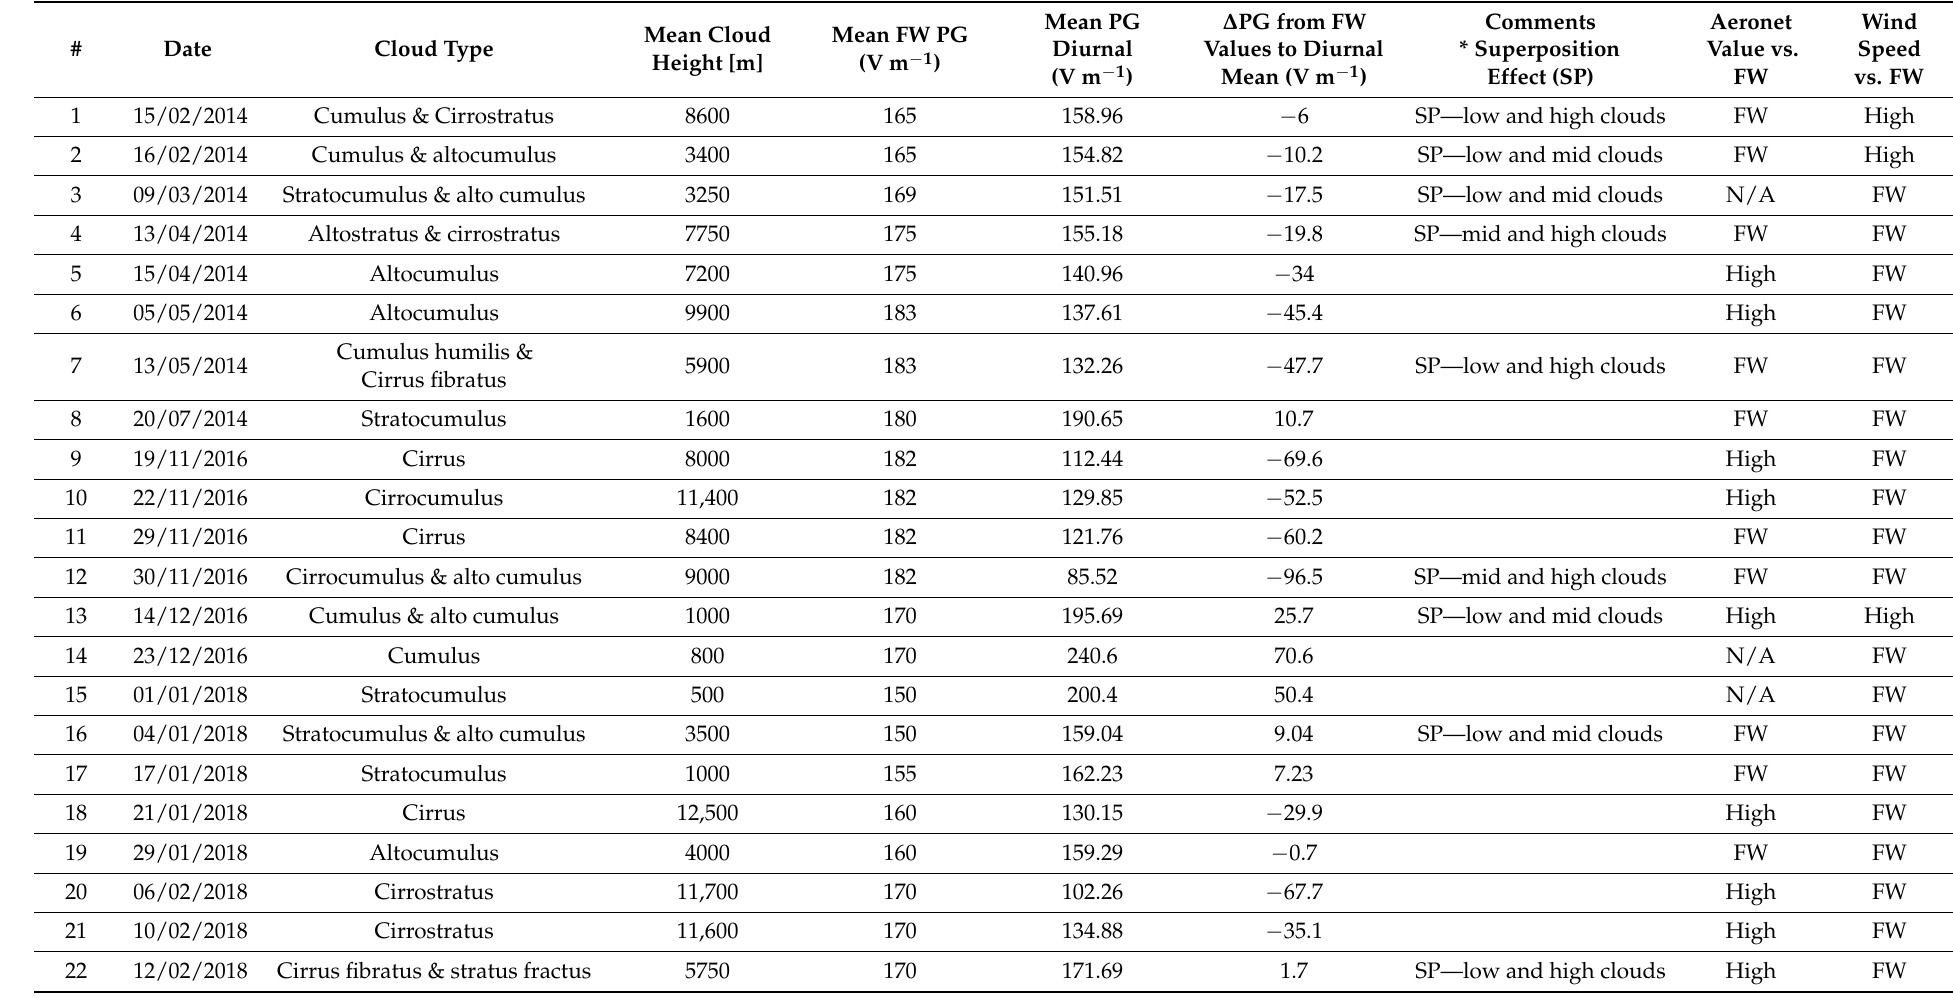
Table 1. 22 case studies on the effect of clouds on measured PG. * This refers to cases when more than one cloud layer was